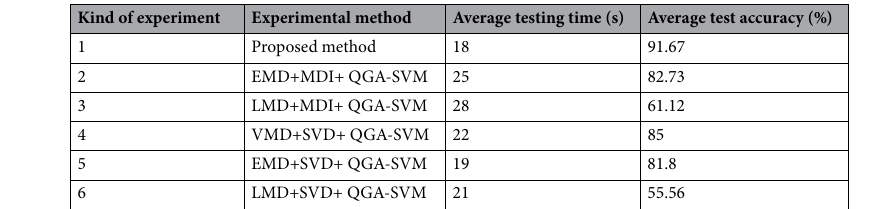
Table 3. Comparison of different feature extraction methods.